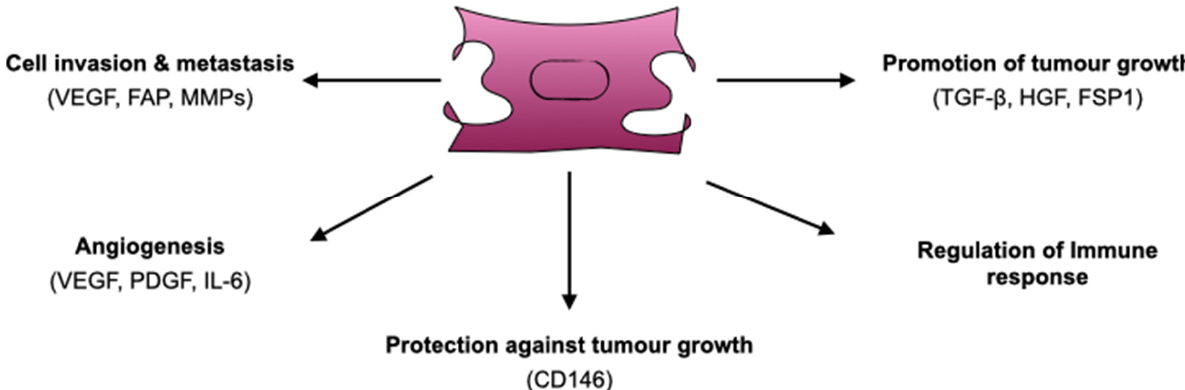
Figure 2. Diverse functions of CAFs: promotion of tumour growth, angiogenesis, cell invasion and metastasis to surrounding tissues, regulation of innate and adaptive immune responses. In addition to tumour-protective roles, CAFs occasionally have anti-tumorigenic functions. VEGF: Vascular Endothelial Growth Factor, FAP: Fibroblast Activation Protein, MMPs: Matrix Metalloproteinases, PDGF: Platelet-Derived Growth Factor, IL-6: Interleukin 6, CD146: Cluster of Differentiation 146, HGF: Hepatocyte Growth Factor, FSP1: Fibroblast-specific Protein 1.